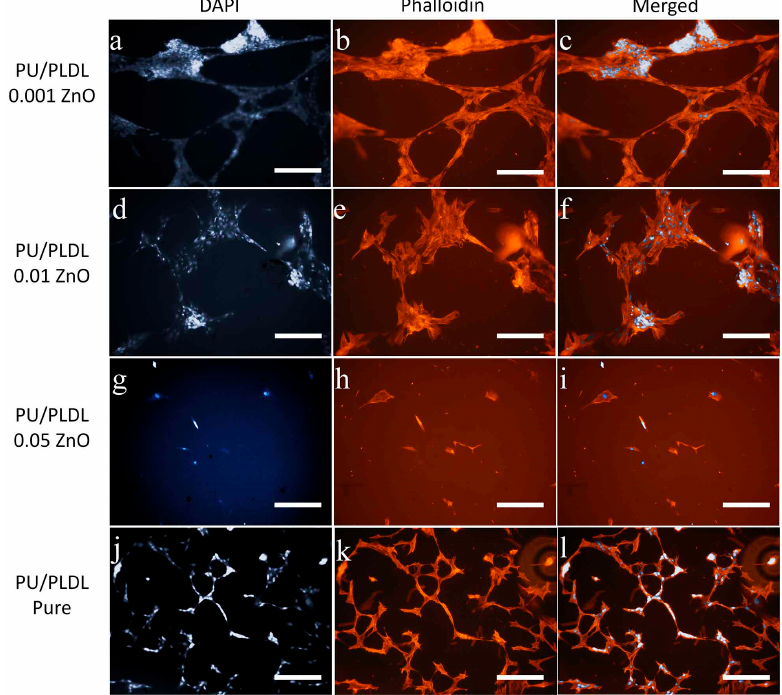
Figure 6. Adipose stem cells cultured on different experimental polymer substrates stained histochemically for nuclei (DAPI, a , e , i , m ), and actin (phalloidin, b , f , j , n ), and the cell morphology visualized with SEM ( d , h , l , p ); cell connections marked with arrowheads; magnifications 100× (fluorescence, scale bar = 200 µm).